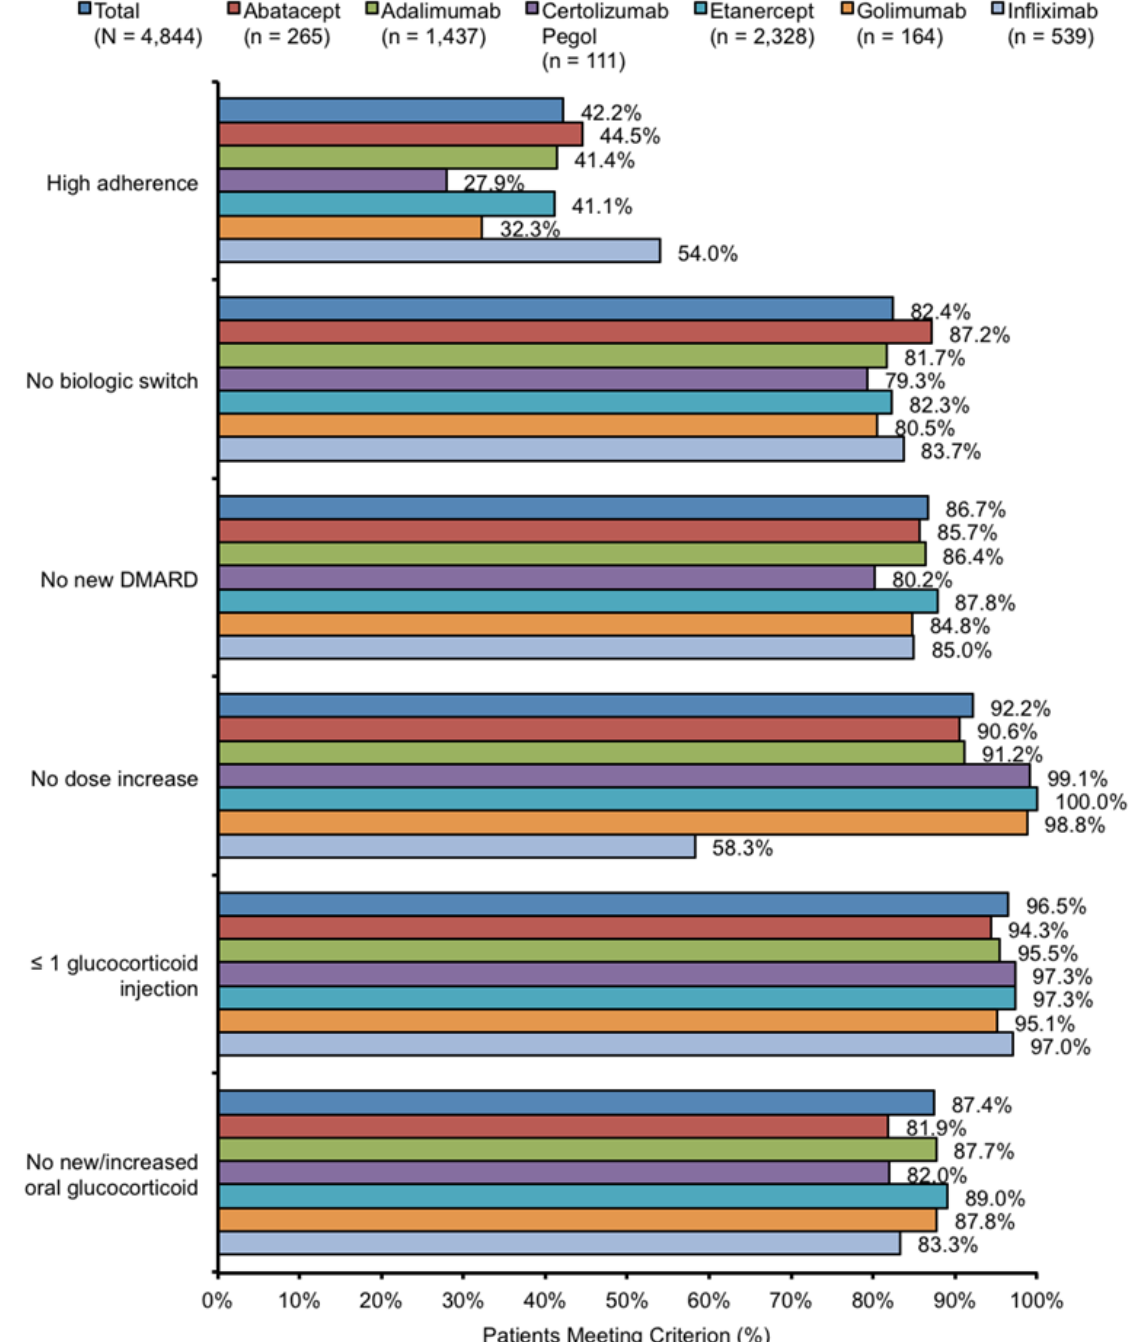
Figure 1. Percentage of Patients Meeting Individual Algorithm Criteria